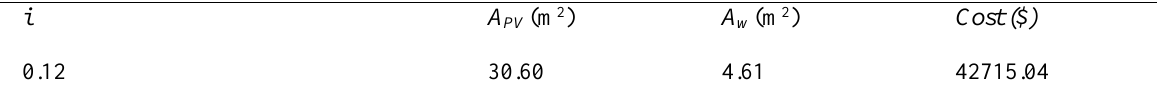
Table 2. The Optimally Measured Results Correspond to the Best Performance of the Algorithm.